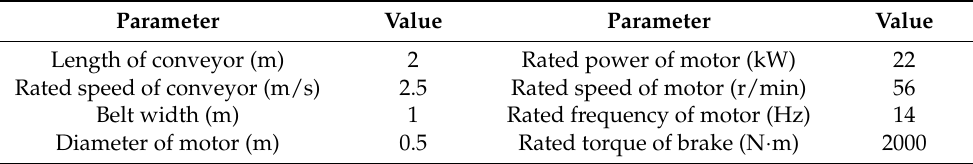
Table 2. Specific parameters of experimental platform for the belt conveyor.